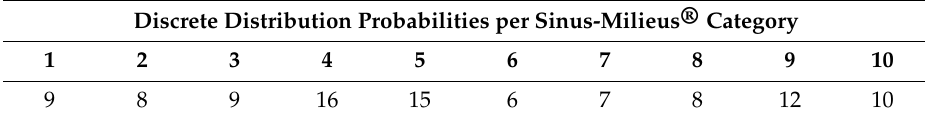
Table A7. Probability to belong to a Sinus-Milieus ® category.